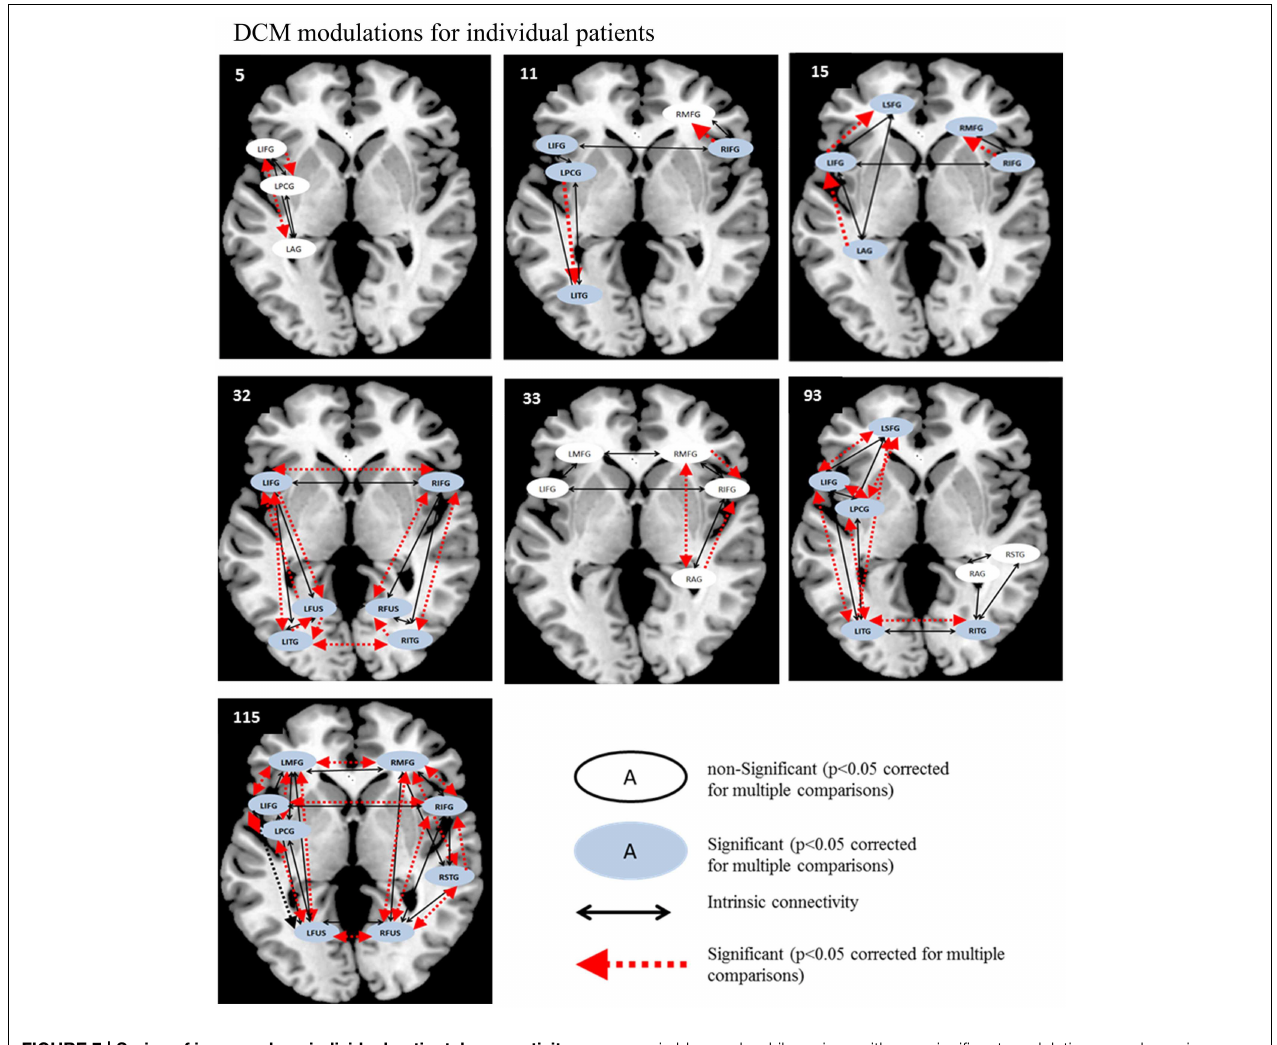
FIGURE 7 | Series of images show individual patients’ connectivity networks as a function of rehabilitation for the trained category on the picture naming task. Regions with significant modulations are shown